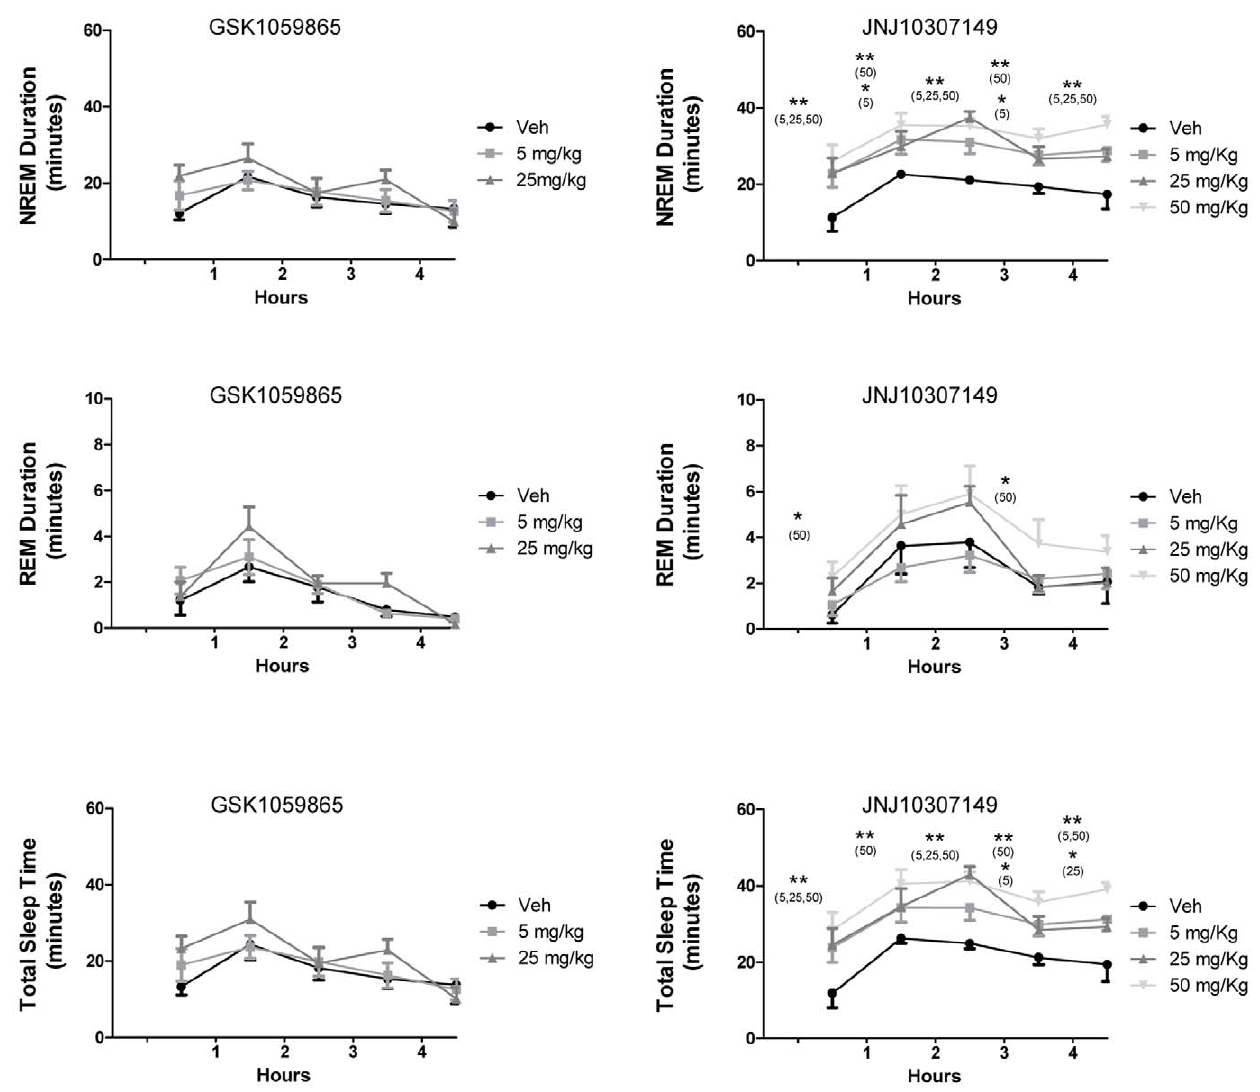
Figure 6. Sleep-promoting effects of selective OX1R or OX2R antagonism. Sleep-promoting effects (NREM, REM and total sleep time) of selective OX1R (Left; GSK1059865, 5 and 25 mg/kg i.p.) or OX2R antagonism (Right; JNJ-10397049; 5, 25, and 50 mg/kg) versus vehicle. Data are expressed in minutes and are represented as means 6 S.E.M. Values were rebinned in 1-hour intervals to cover the whole 5-hour time-window recorded. (*, P , 0.05 and **, P , 0.01, treatment versus vehicle, on one-way ANOVA followed by Newmann-Keuls test). Doses that produced statistically significant effects are indicated in parenthesis above the corresponding time-point.